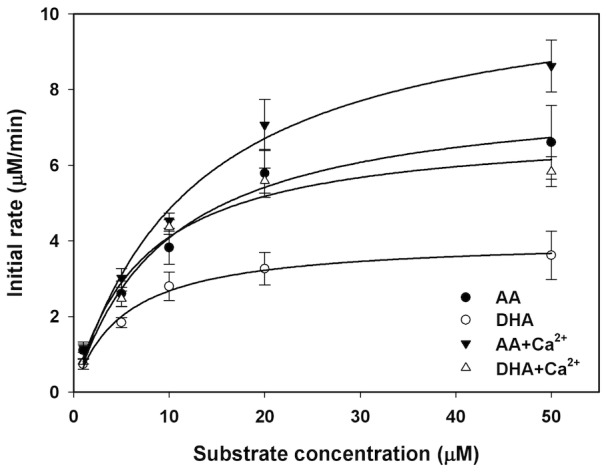
Human 12-LOX converts AA and DHA with essentially equivalent efficiency.Increasing concentrations of AA or DHA (1 to 50 µM) were mixed with 12-LOX (0.1 µM, pH 8.0, R.T.) in the presence or absence of CaCl2 (2 mM). Initial rates were monitored and plotted versus substrate at indicated concentrations. Each point represents mean±SEM from n = 3 separate experiments.